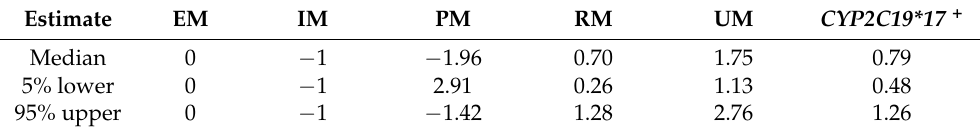
Table 2. Estimates and 90% credibility intervals of activity scores after excluding RM pooling. Estimate EM